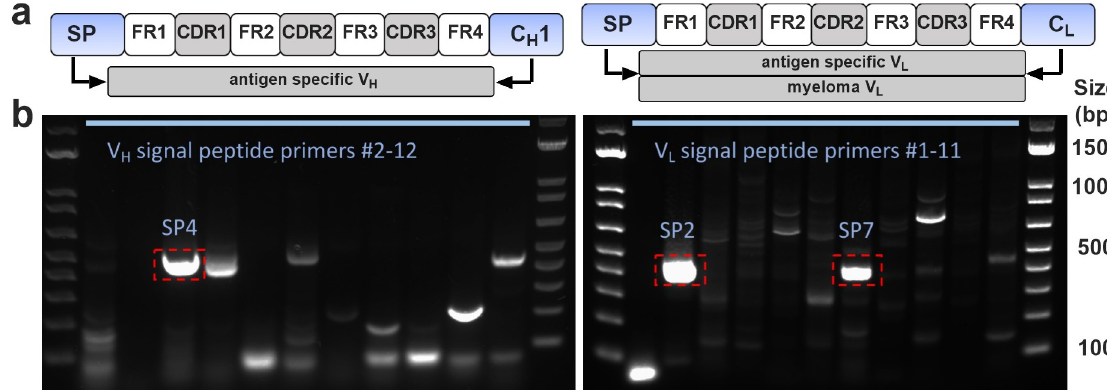
Fig 1. (a) Schematic of PCR amplification of V H and V L cDNAs by signal peptide (SP) primers. Right panel shows light chain PCR, which typically results in amplification of myeloma cDNA by some primers (primarily SP2) and antigen specific cDNA by other SP primers. (b) DNA gels. For the heavy chain (left panel), SP4 gave the major product, which was sequenced and revealed a full-length V H cDNA. For the light chain (right panel), SP2 amplified the non-productive Sp2/0 myeloma kappa chain, whereas SP7 primer amplified a full-length V L